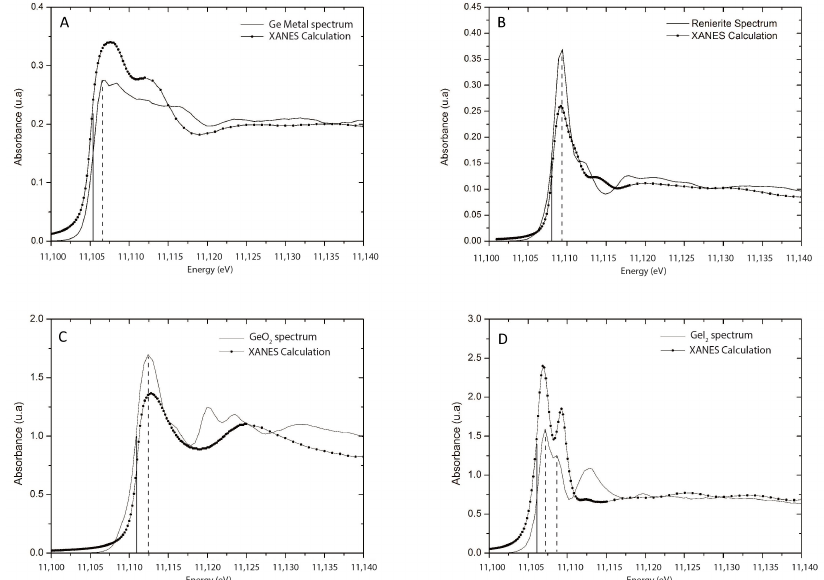
Figure 3. Standard experimental spectra compared to the XANES calculations, performed to verify the main peak position of each standard. Dotted lines indicate the position of the main peaks and solid lines indicate the position of the edge. ( A ) Ge metal spectra; ( B ) Renierite spectra; ( C ) GeO 2 spectra and ( D ) GeI 2 spectra.